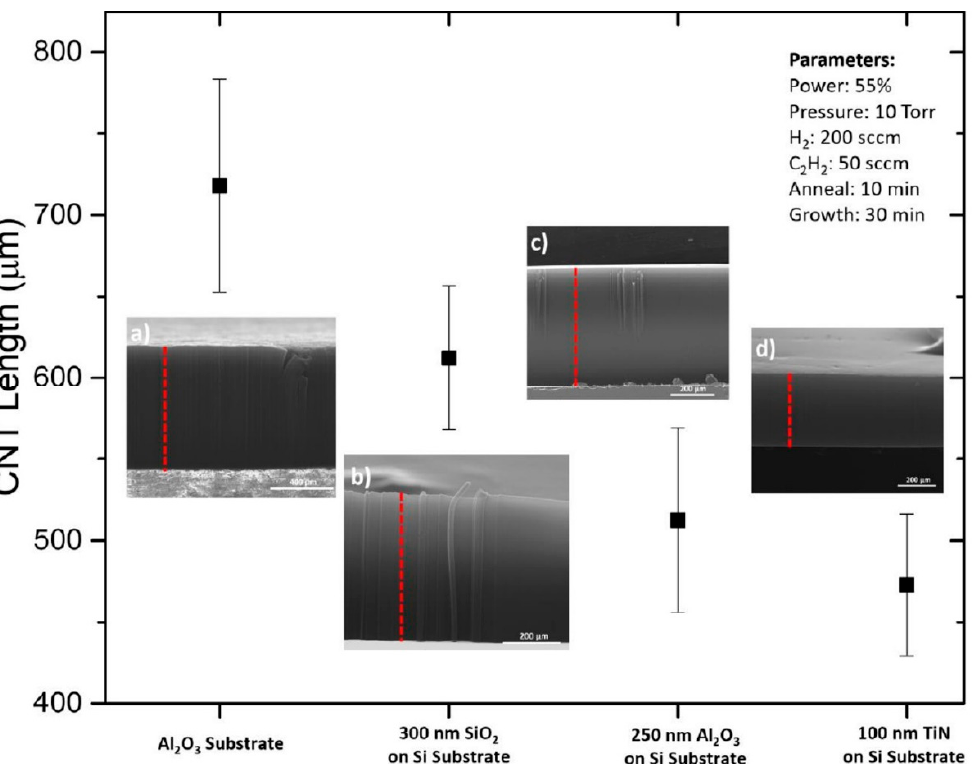
Figure 13. Length of VACNT (from 3 repetitions of each substrate) as an effect of the different DBL/thermal barrier layers. SEM micrograph inserts of ( a ) Al 2 O 3 ( b ) 300 nm SiO 2 on Si substrate ( c ) 250 nm Al 2 O 3 on Si substrate ( d ) 100 nm TiN on Si substrate, where all four substrates had a 10 nm Al top-layer and a 3 nm Fe catalyst layer on the upper-most surface. Scale bar in ( a ) 400 µm, ( b – d ) 200 µm. Reported in [60].